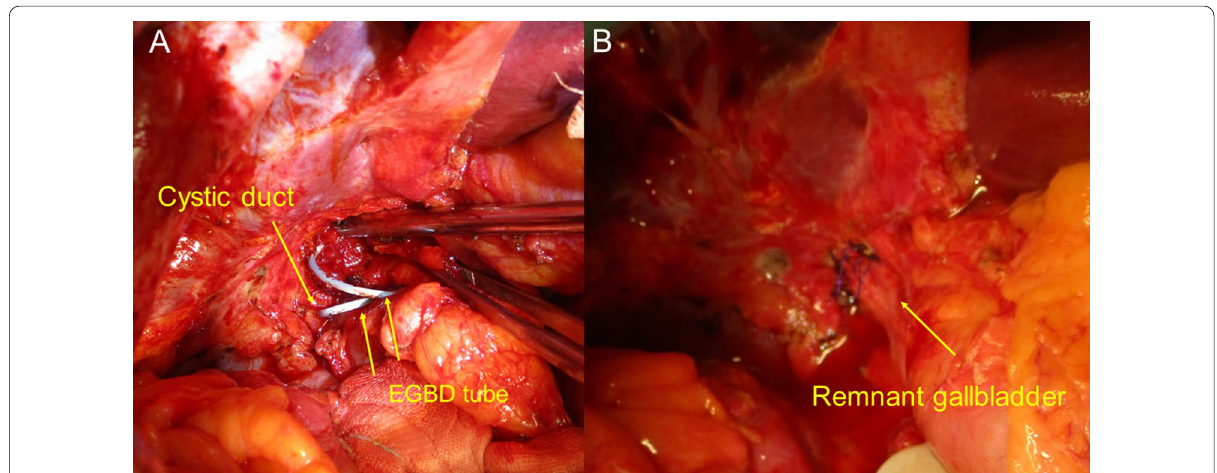
Fig. 2 Intraoperative images of case 1. a After opening the wall of the remnant gallbladder, the EGBD tube was identified. b The remnant gallbladder wall was